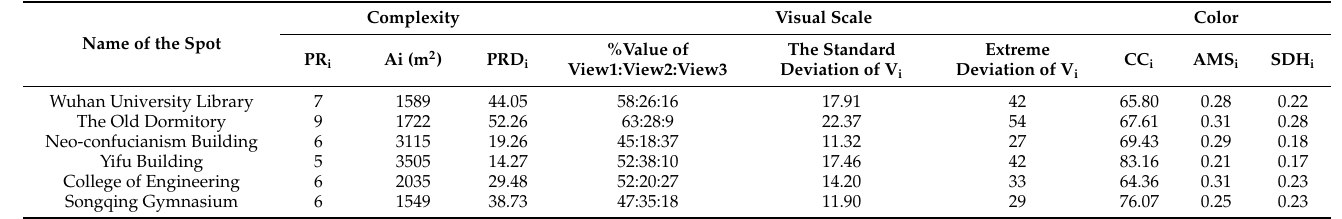
Table 2. Values of landscape visual indicators depicted in photographs in each study scenic spot.